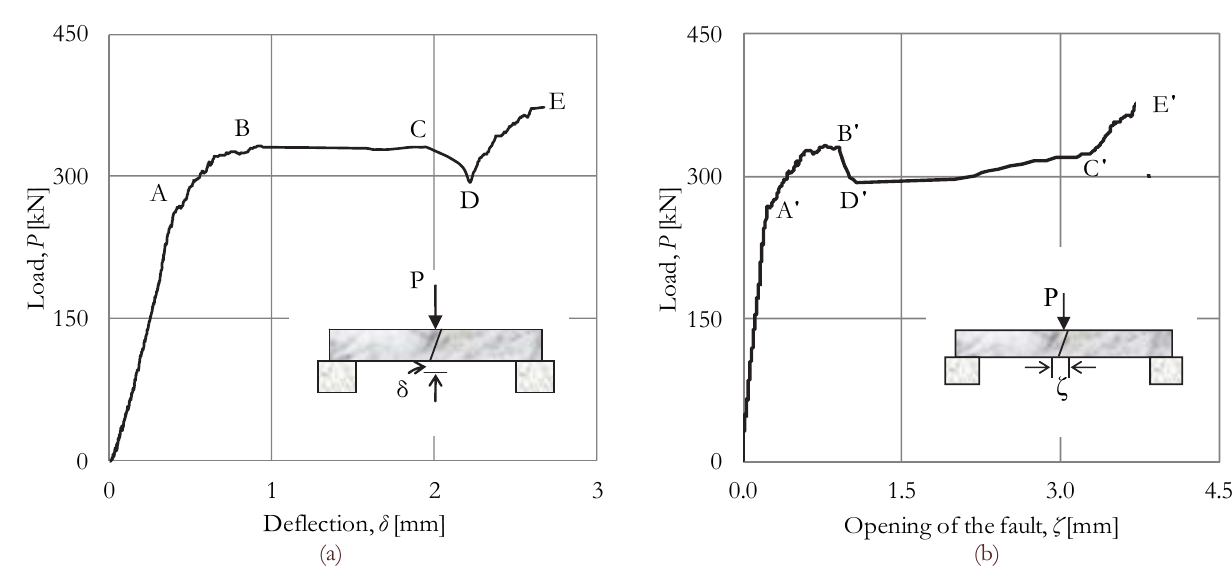
Figure 3: The overall load imposed versus the (a) deflection, δ , of the epistyle’s central section and (b) the opening of the fault, ζ , at the lowest edge of the epistyle.